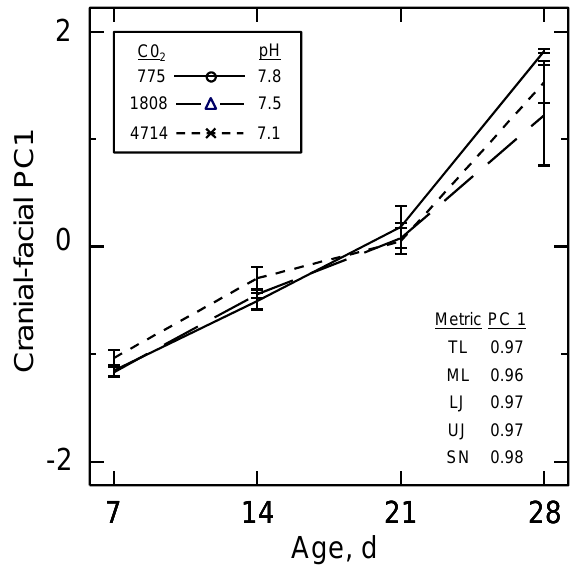
Fig. 6. Responses in cranio-facial features of summer flounder lar- vae by age at different levels of CO 2 in rearing water (inset: CO 2 levels (µatm) and associated pH values). Responses are as summa- rized by the first principal component (PC) scores. The PC load- ings on each original cranio-facial measurement (metric) are shown within panel. Plotted data are means ± SE. See Sect. 2.4.3 for de- scription of measurements and abbreviations, and Table S3 for sum- mary